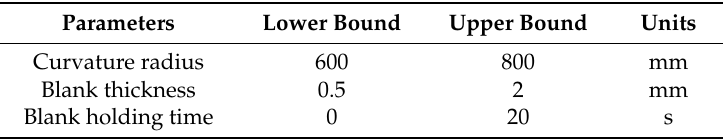
Figure 6. Target curvature radius with the deformed result of R = 600 mm and R = 800 mm curvature radius after springback.s